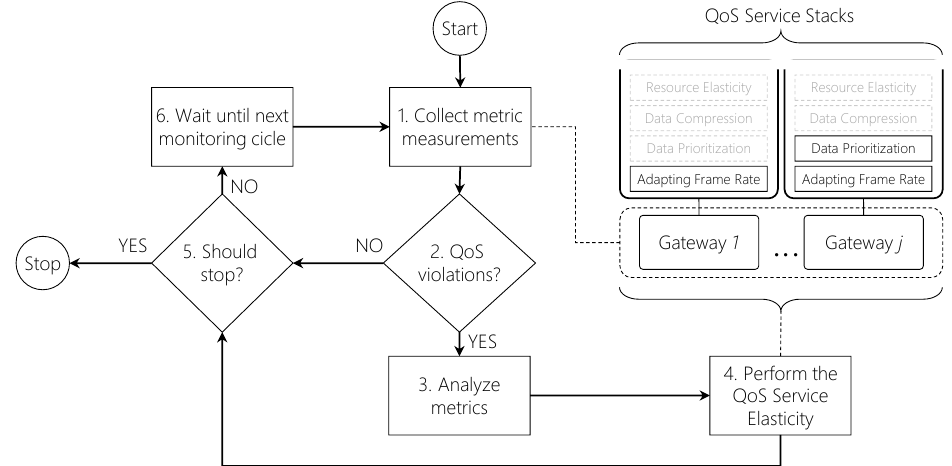
Figure 3. QoS Service Elasticity decision loop depicting the steps the Core performs to deliver QoS